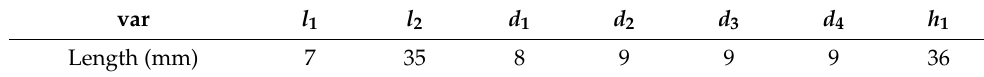
Table 1. The parameter of the parallel control mechanism. var l 1 l 2 d 1 d 2 d 3 d 4 h 1 Length (mm) 7 35 8 9 9 9